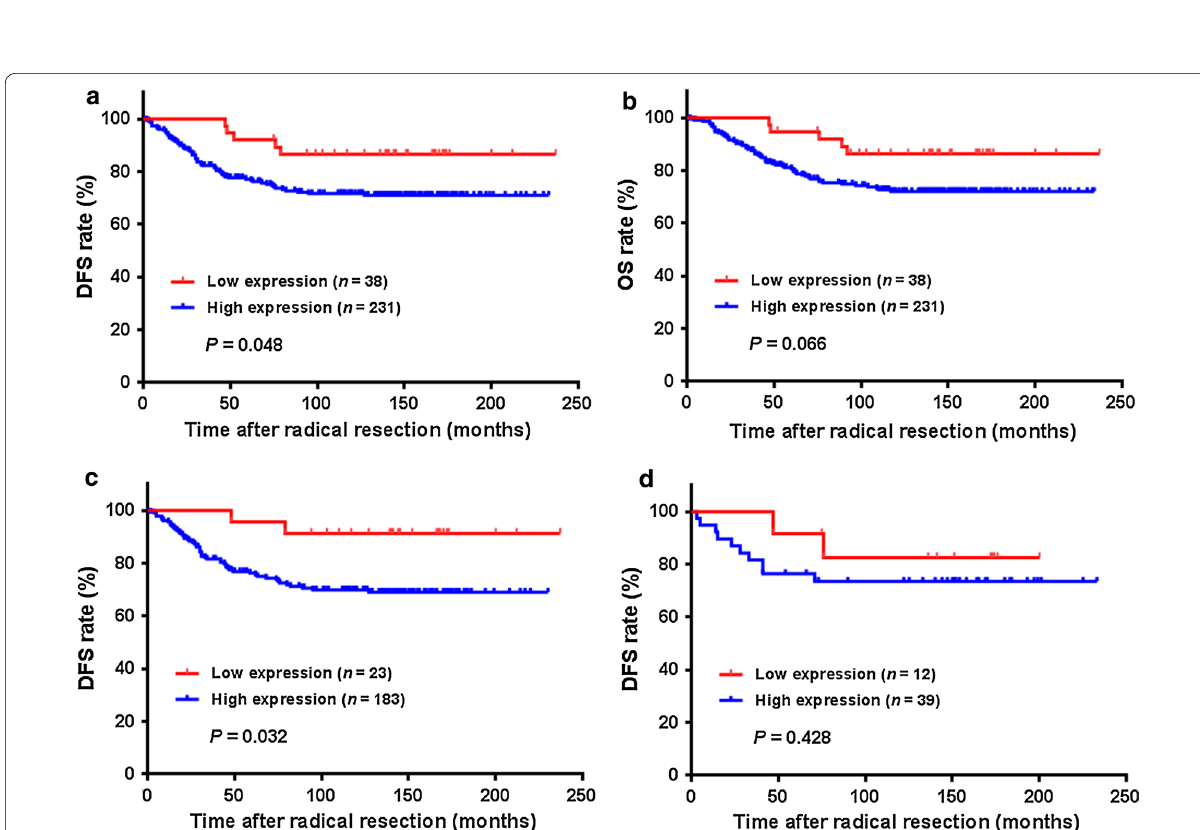
Fig. 4 Kaplan–Meier curves comparing 5-year survival outcome of colon cancer patients with high and low Nav1.5 expression. a There is no signifi- cant difference in overall survival. b Disease-free survival (DFS) is significantly shorter in patients with high Nav1.5 expression than in those with low expression. c In patients with high ER-β expression colon tumor, DFS is significantly shorter in patients with high Nav1.5 expression than in those with low expression. d In patients with low ER-β expression colon tumor, there is no significant difference in DFS between the two